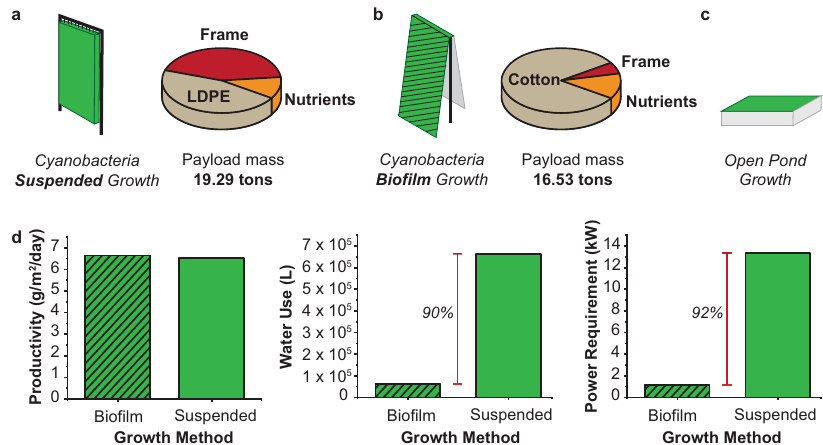
Fig. 4 Cyanobacteria cultivation unit metrics required for the bio-ISRU production of 2,3-BDO. Schematic of cyanobacteria growth systems (green) and payload mass broken down into nutrients (orange), frame (red) and material (brown): a Suspended growth: cyanobacteria grown in photobioreactors (0.3 mm-thick low-density polyethylene, LDPE) fi lled with water; b Bio fi lm growth: cyanobacteria grown in a thin fi lm on a porous substrate (0.3 mm thick cotton fabric); c Open pond: cyanobacteria grown open to the atmosphere. Not evaluated for use on Mars. d Cyanobacteria biomass productivity, water use and power requirement for bio fi lm and suspended growth. Results are based on 10 tons of 2,3-BDO produced over 500 sols. Source data underlying a , b , and d are provided as a Source Data fi